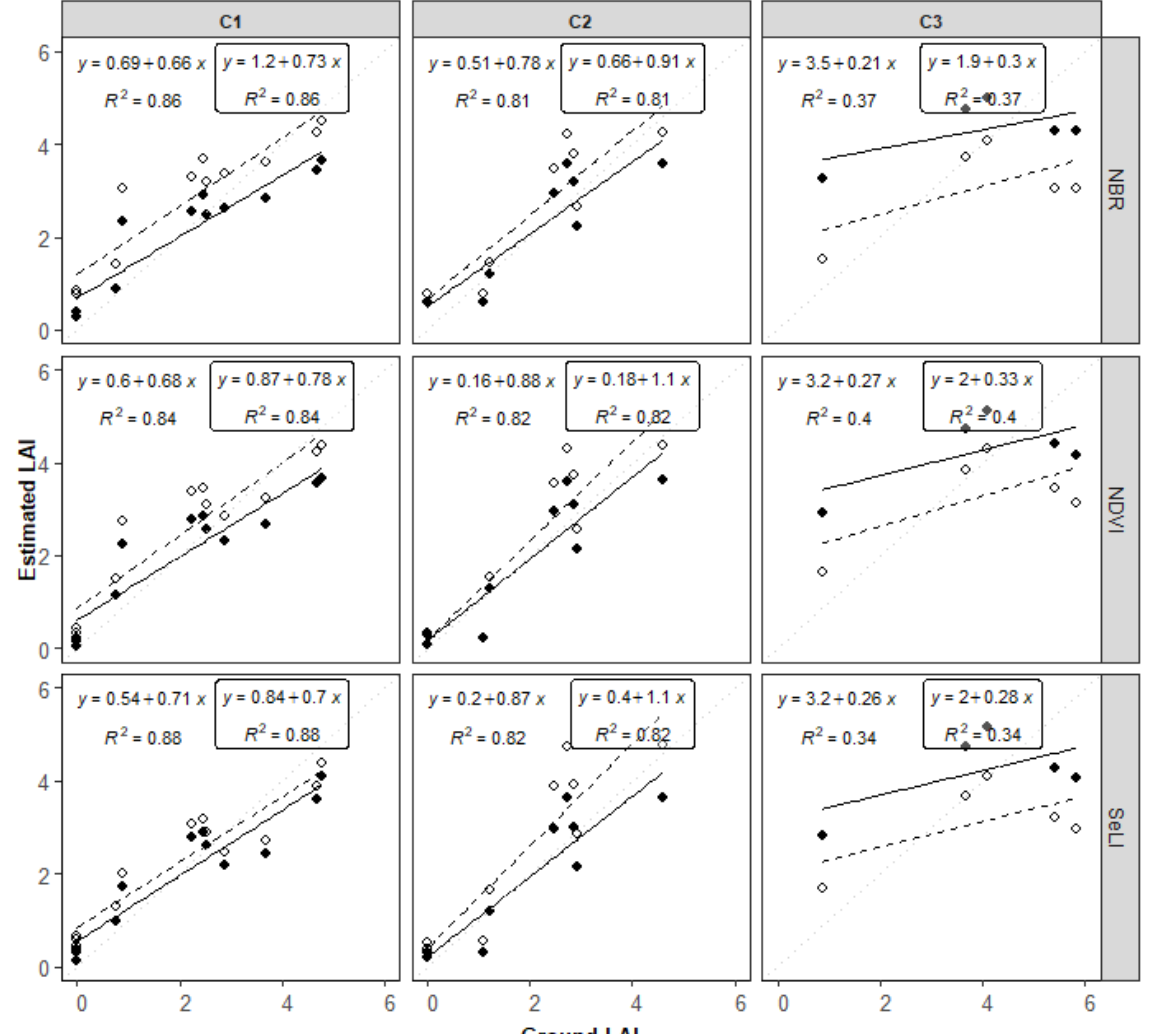
Figure A5. Results per crop (C1, C2, and C3) of linear regression analysis between measured ground-LAI and LAI predicted from NDVI, SeLI, and NBR by the mixed-crop (MC) LM (dashed line on black dots and equation in the box) and the crop-specific (CS) LM (continuous line on black dots).